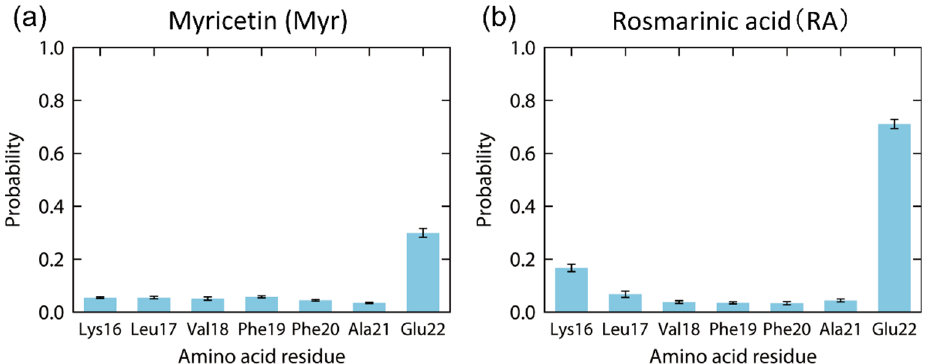
Figure 12. Contact probability of each amino acid residue of the A β (16–22) peptide with ( a ) myricetin and ( b ) rosmarinic acid at 300 K. Reprinted with permission from Reference [26]. Copyright 2020 Elsevier.